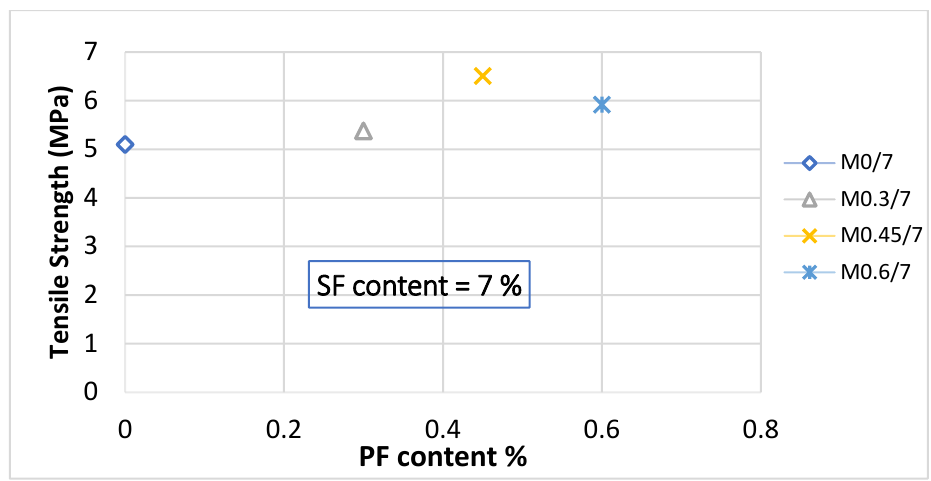
Figure 13. Effect of polypropylene fiber content on tensile strength under ambient conditions.